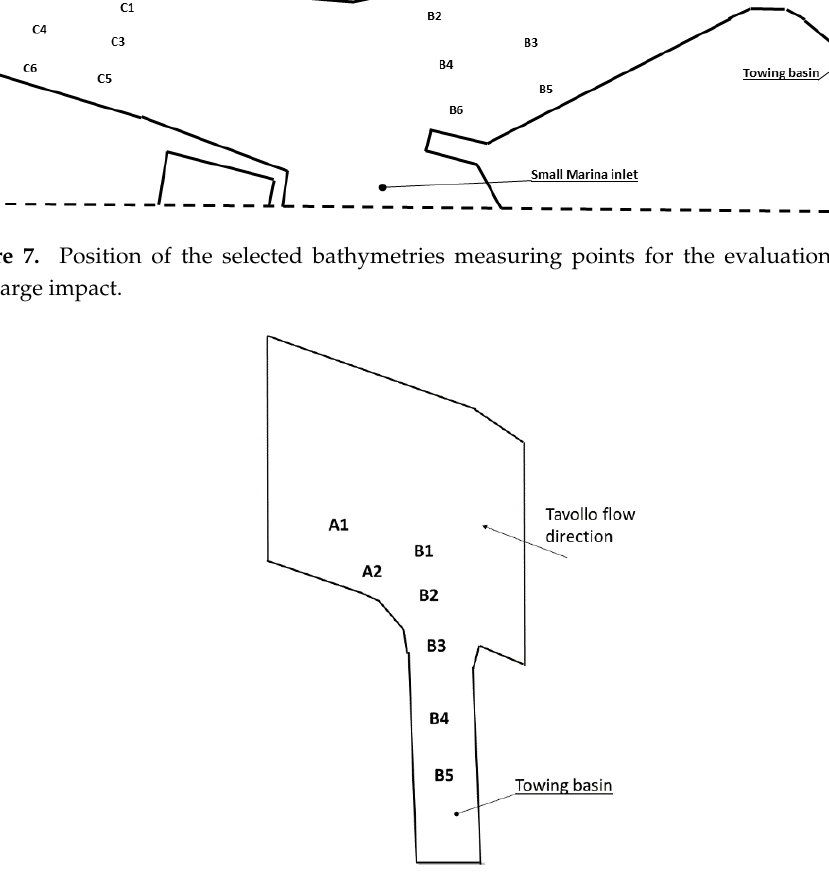
Figure 8. Position of the selected bathymetries measuring points for the evaluation of ejectors effectiveness in the towing basin area.